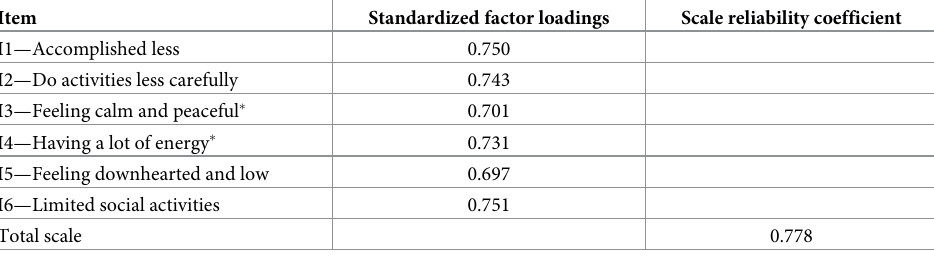
Table 2. Weights (principal components loadings) and internal reliability of the mental health summary measure.